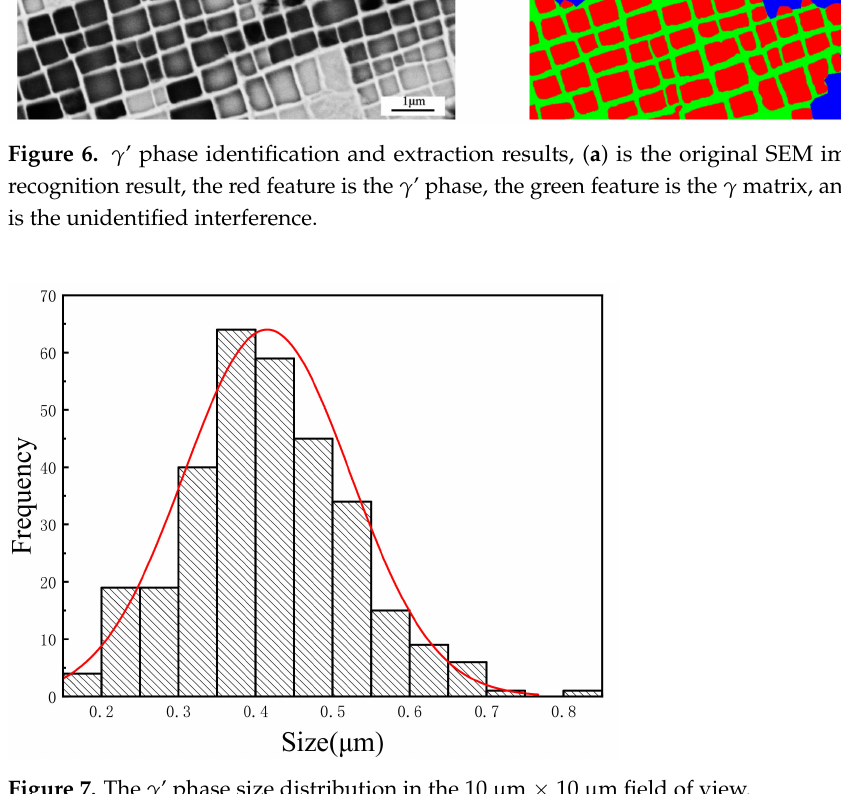
Figure 7. The γ ’ phase size distribution in the 10 µ m × 10 µ m field of view. Table 2. Statistical results of related parameters of γ ’ phase in 10 µ m × 10 µ m field of